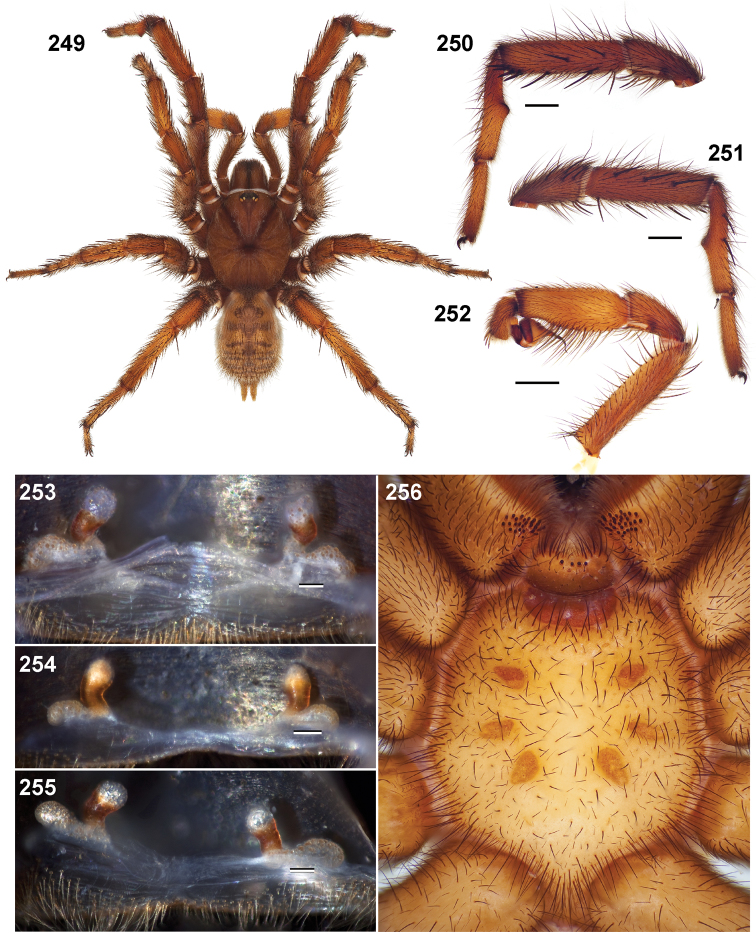
Aptostichus mikeradtkei sp. n. 249–252 male holotype (AP1085), from San Diego Co.; scale bars = 1.0mm. 249 habitus [806034] 250 retrolateral aspect, leg I [806032] 251 prolateral aspect, leg I [806028] 252 retrolateral aspect, pedipalp [806036] 253–255 cleared spermathecae; scale bars = 0.1mm 253 female paratype (AP1148) [806705] 254, 255 additional specimens from vicinity of type locality (AP1155, 1247) [806620, 806623] 256 sternum of paratype female (AP1148) [806038].